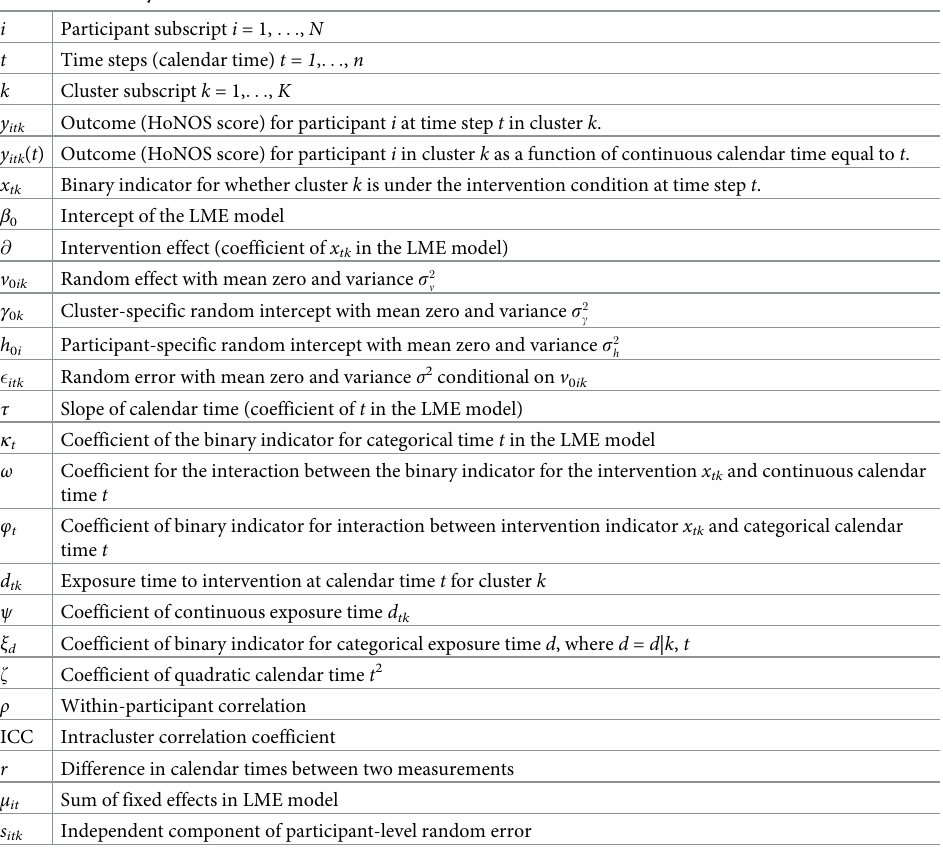
Table 1. Summary of mathematical notation. i Participant subscript i = 1, ... , N t Time steps (calendar time) t = 1 , ... , n k Cluster subscript k = 1, ... , K y itk Outcome (HoNOS score) for participant i at time step t in cluster k